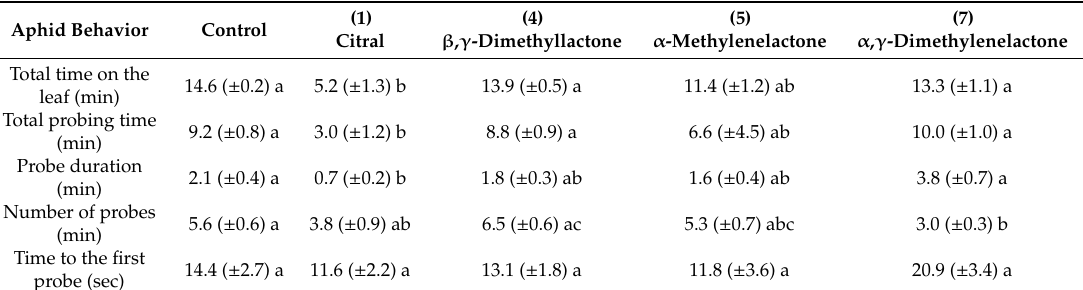
Table 2. Responses of Myzus persicae to citral and citral-derived lactones during the 15 min video recorded free access to treated and untreated (control) leaves. Values represent means ( ± SE), n = 16; di ff erent letters in rows show significant di ff erences at p < 0.05 (Kruskal–Wallis test). (1) (4) (5) (7) Aphid Behavior Control β , γ -Dimethyllactone α -Methylenelactone α , γ Citral